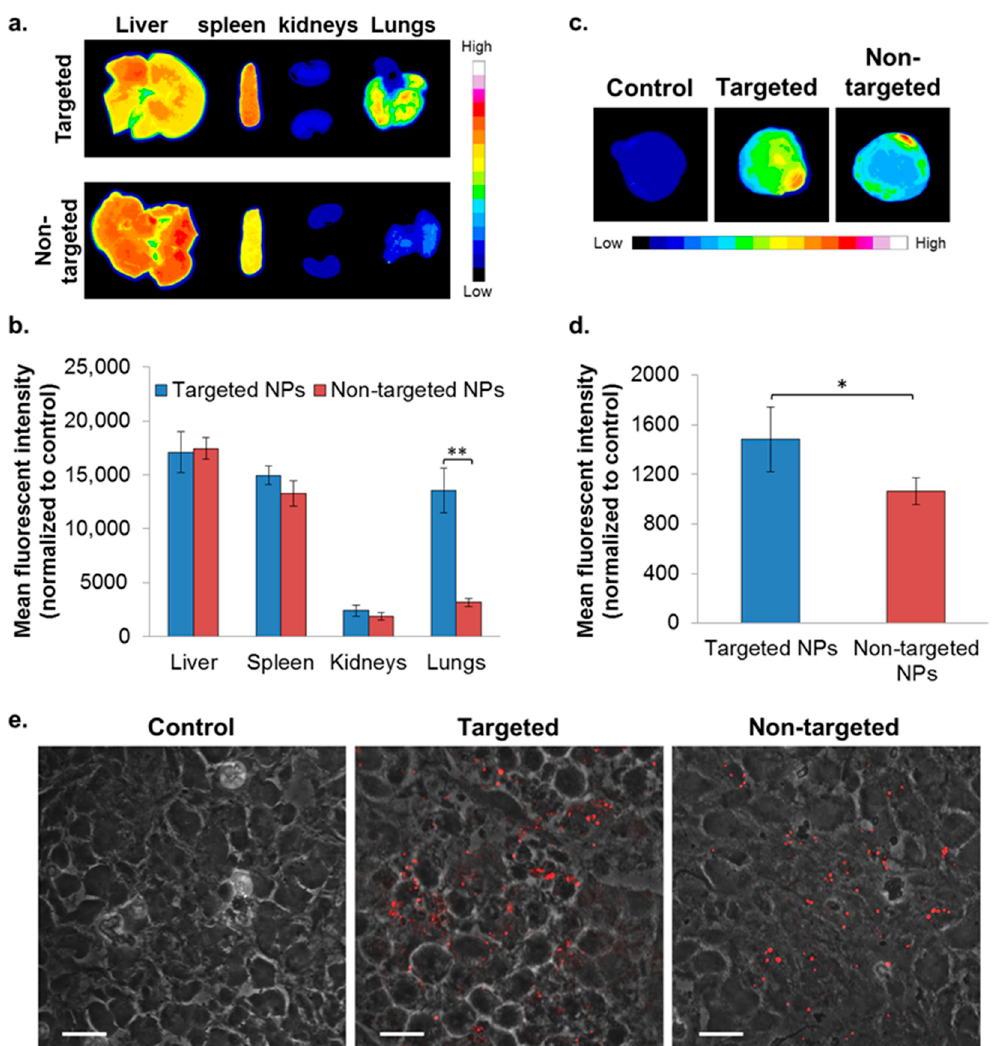
Figure 5. Biodistribution of NPs in the orthotopic xenografted mice model of MDA-MB-231 human mammary carcinoma cells. NPs biodistributions in selected organs ( a , b ) and in the primary tumor site ( c , d ) following treatment with targeted ( n = 2) and non-targeted ( n = 3) NPs was determined by Typhoon images followed by ImageJ analyses, 24 h after IV treatment. The mean fluorescent intensity in each organ was normalized to untreated control (mean ± SD, ** p < 0.01, and * p < 0.05). Representative confocal microscopy images for qualitative assessment of NPs accumulation in tumor cryosections is shown in ( e ); magnification 60 × ; size bar, 20 µ m. NPs are shown in red (PLGA-Cy5). The fluorescent intensity was normalized to tumor cryosections of untreated control.